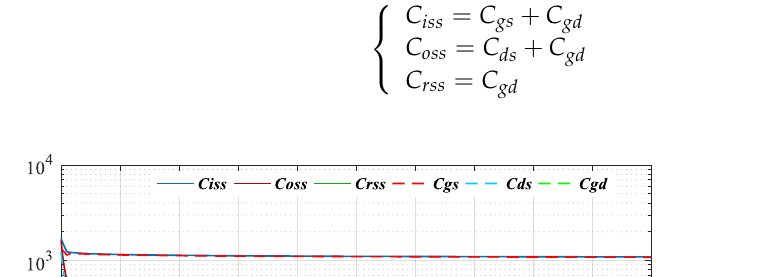
Figure 8. Comparison between the data from datasheet and the simulation. Interelectrode capacitances are usually used in actual model establishment and calculations, which can be extracted according to Equation (10). Their comparison with the datasheet curves is shown in Figure 9. Since C gs and C ds are much larger than C gd , the interelectrode capacitances curves are almost the same with the parasitic capacitance curves from the datasheet.